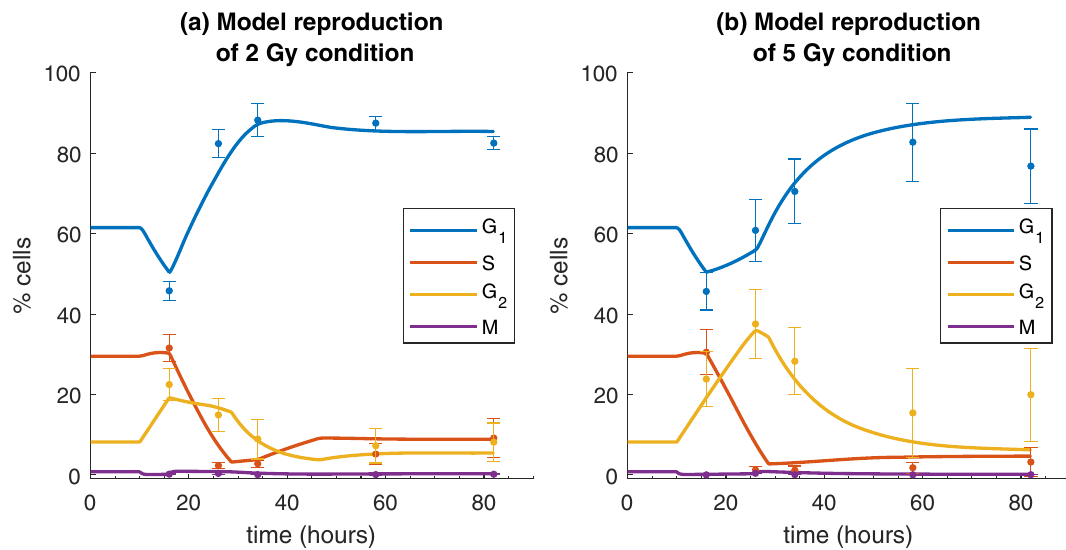
Figure 6. Model perturbation for cell-cycle phases over time. Model perturbation for the 2 Gy condition (a) , and for the 5 Gy condition (b) . The model is in the unperturbed condition up to 10 h, cells are irradiated at t = 10 h. Errors are reported as standard deviations at 1 σ